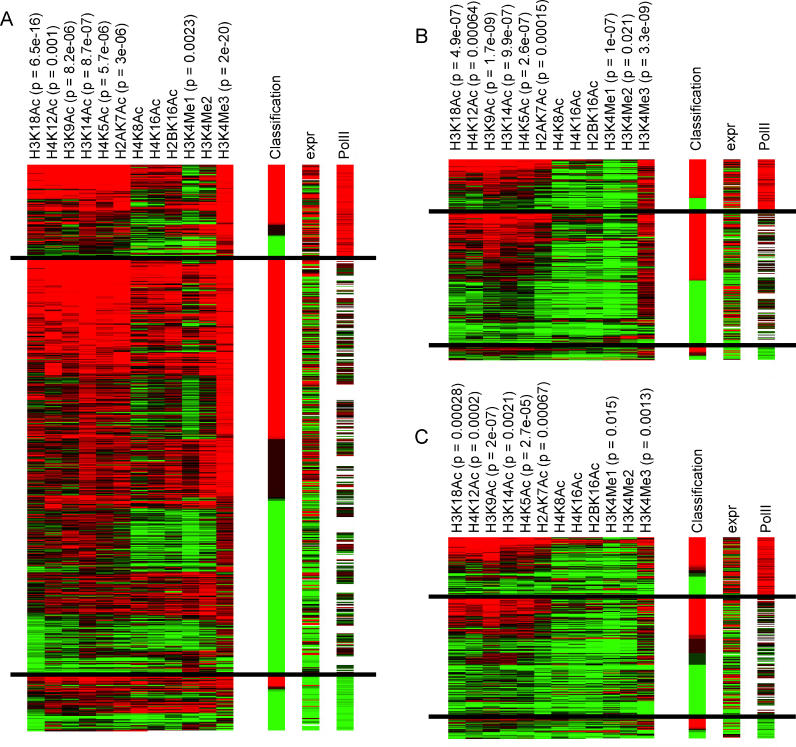
Nucleosome Modifications Relate to Transcription Level(A) Classification plot of nucleosomes in 5′-coding regions according to PolII occupancy. A classifier was trained to distinguish between nucleosomes with high and low PolII occupancy, and evaluated using leave-one-out cross-validation. Each row corresponds to one nucleosome. Nucleosomes are split into three groups associated with genes corresponding to high, intermediate, and low PolII occupancy level (from top to bottom, respectively). The left 12 columns denote modification patterns of each nucleosome. Modifications with significant differences between high and low nucleosomes are marked with the p-value determined by t-test. Colours denote relative acetylation/methylation levels. The rightmost three columns correspond to the classifier's prediction of transcription, the expression level (mRNA abundance; see Materials and Methods) and the PolII occupancy of genes. The average accuracy of random classification was 60.71%, with a standard deviation of 4.3%. Accuracy of classifier was 75.38% (p < 0.0001).(B) Classification plot of TSS proximal nucleosomes, labelled as in (A). The average accuracy of random classification was 62.45%, with a standard deviation of 4.75%. Accuracy of classifier was 72.8% (p = 0.0004).(C) Classification plot of TSS distal nucleosomes; as in (A). The average accuracy of random classification was 65.79%, with a standard deviation of 4.22%. Accuracy of classifier was 58.4% (p = 0.9333).